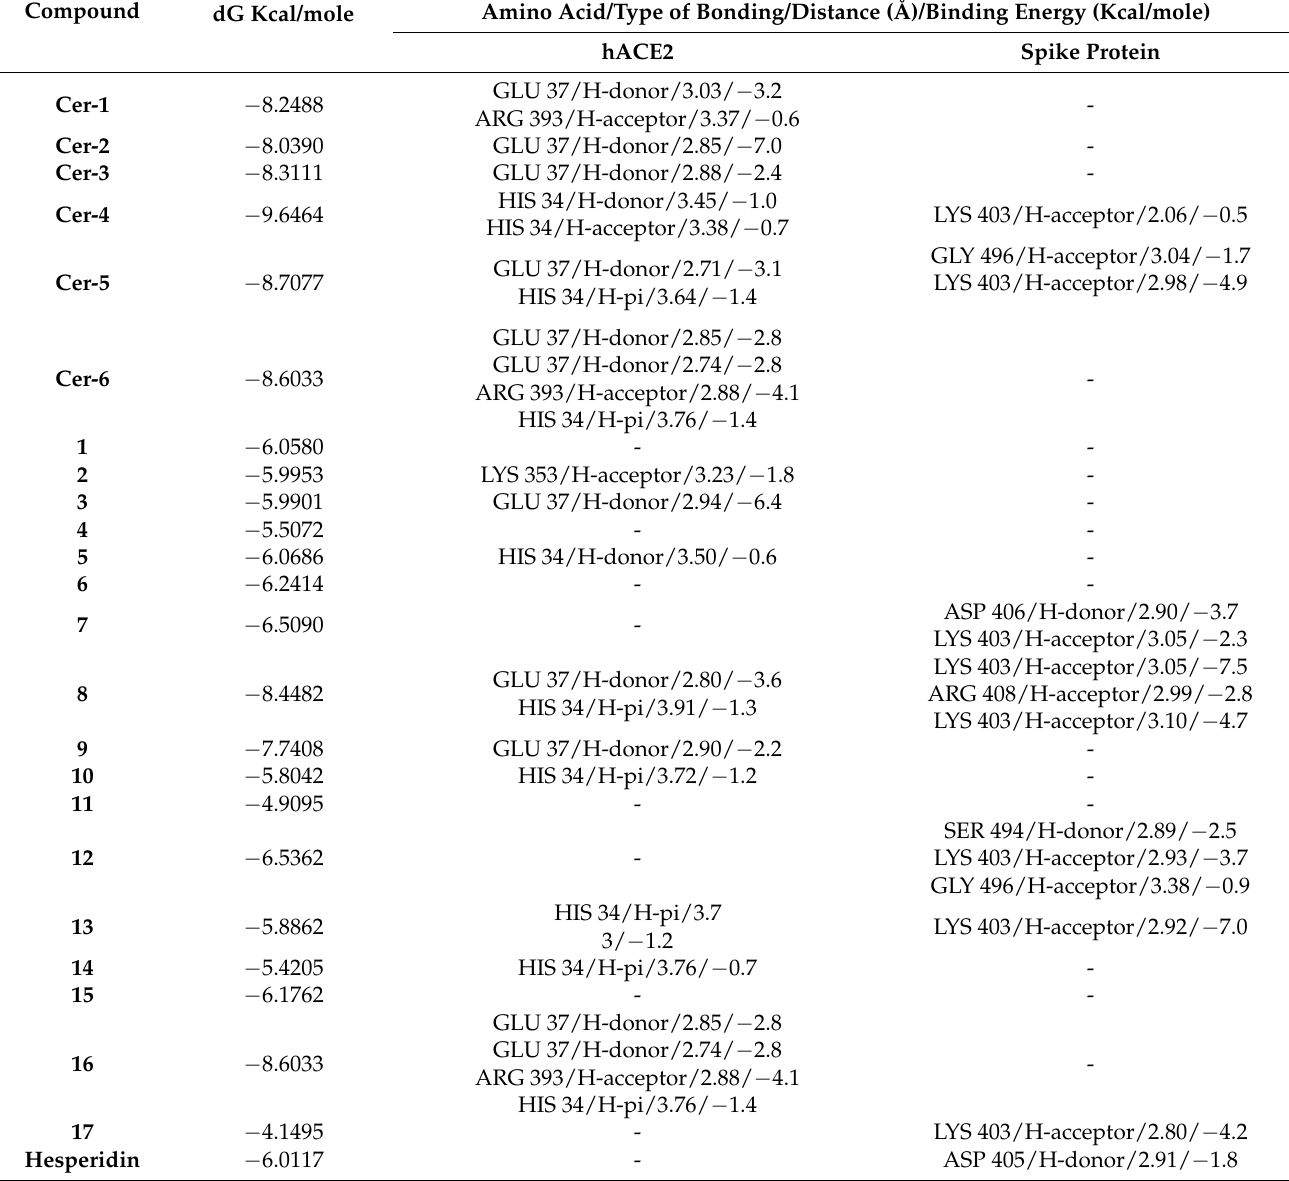
Table 4. Receptor interaction of isolated ceramides, compounds 1 – 17 and hesperidin into the SARS-CoV-2 Spike binding site with